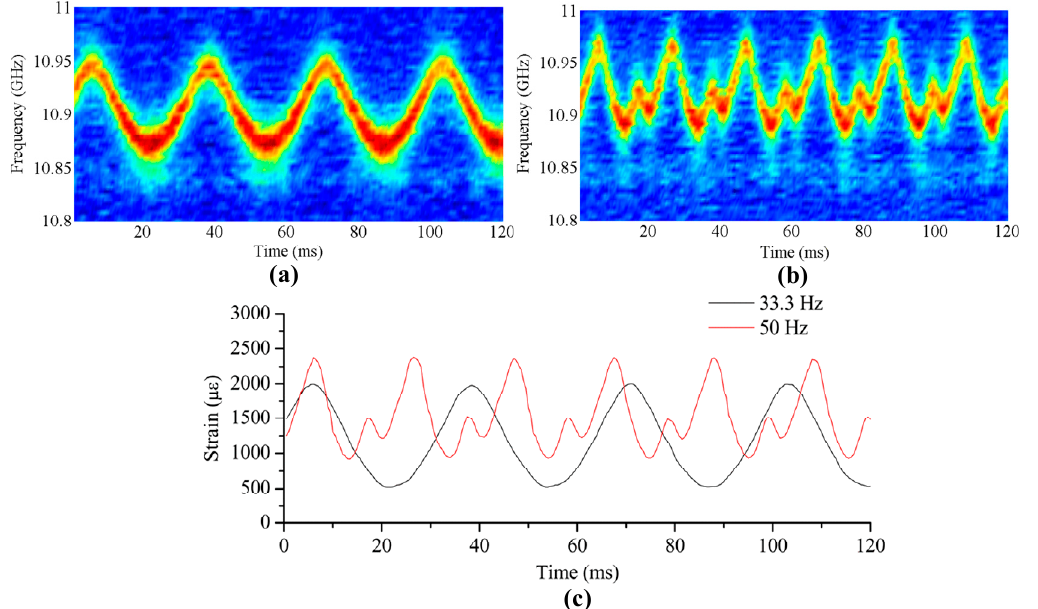
Figure 6. The time-evolutions of the BGS at the vibration section with the frequencies of ( a ) 33.3 Hz and ( b ) 50 Hz. ( c ) The vibration waveforms for the two vibration frequencies [32].